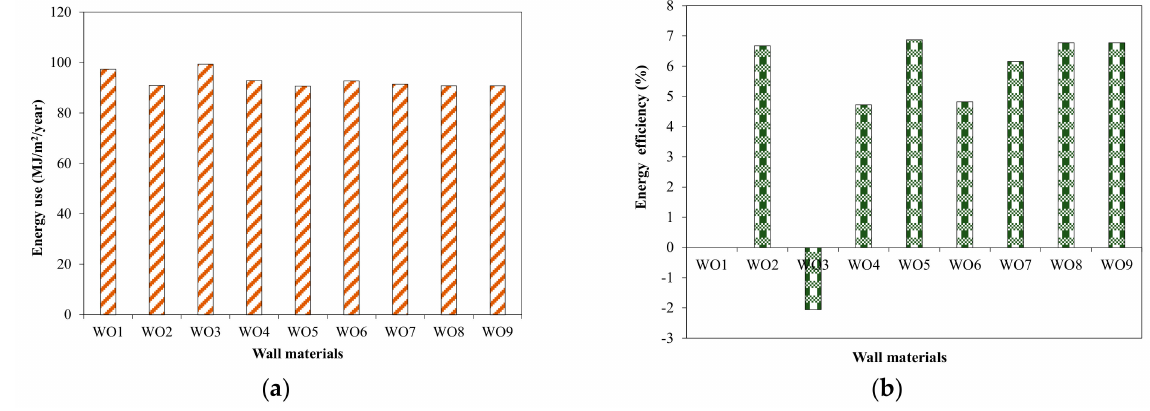
Figure 9. Effect of wall materials on energy use in tested house building. ( a ) Energy use; ( b ) Efficiency.